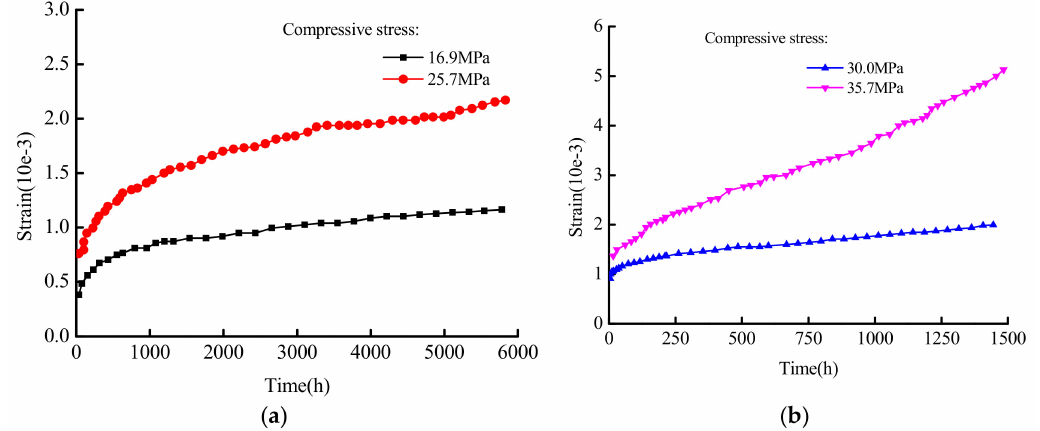
Figure 5. The curve of concrete creep test under di ff erent stress. ( a ) 16.9 MPa and 25.7 MPa; ( b ) 30 MPa and 35.7